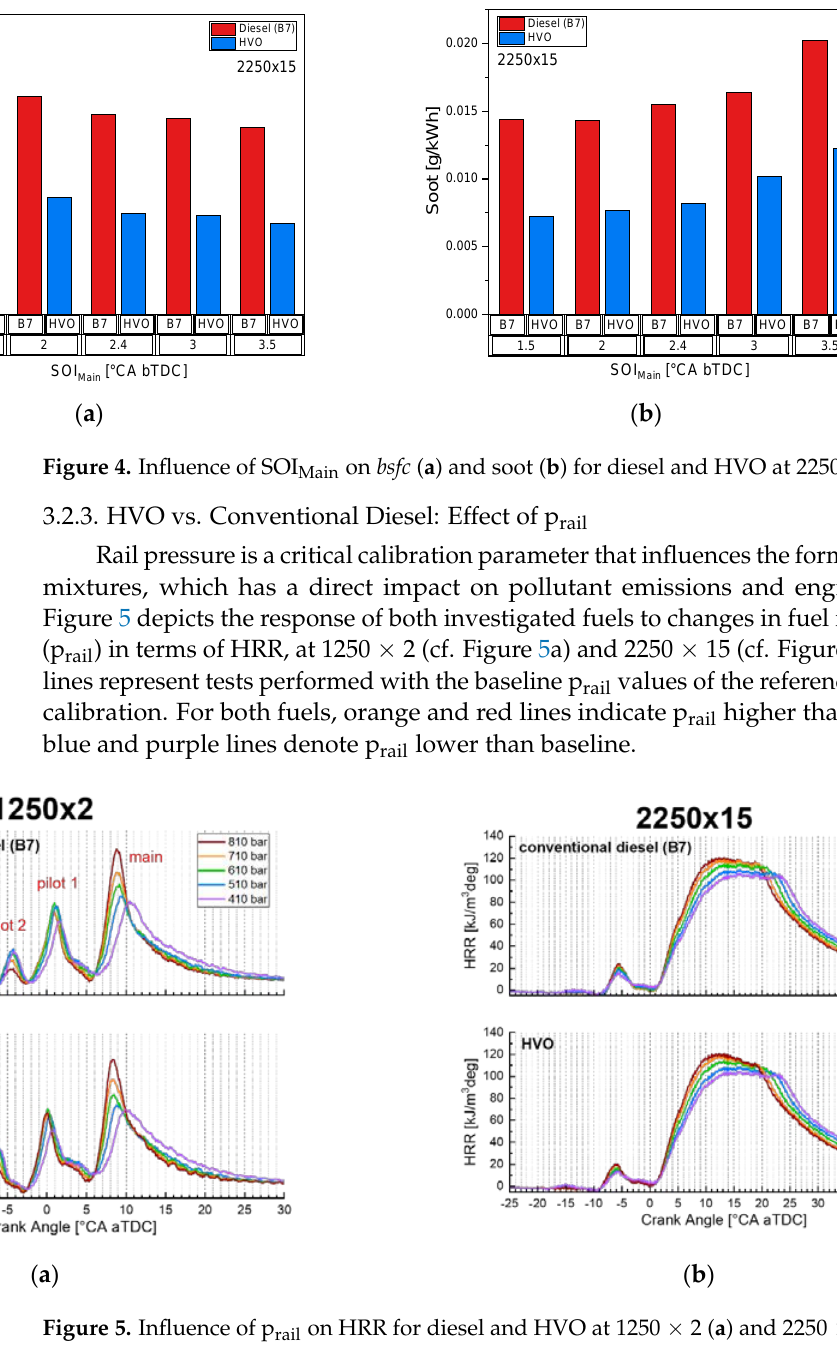
Figure 5. Influence of p rail on HRR for diesel and HVO at 1250 × 2 ( a ) and 2250 × 15 ( b ). When p rail is raised above baseline values at 1250 × 2 (i.e., p rail > 610 bar), the main HRR rises and begins sooner. The increased fuel injection pressure causes the fuel spray of the main injection to reach faster the pilot-burning zone, resulting in a shorter ID of the main injection (ID Main ) and a faster, closer-to-TDC combustion process, due to hotter in-cylinder conditions. However, as p rail values are raised from 610 to 810 bar, the earliest HRR of pilot 2 declines, implying that less fuel is burned during this phase, whereas no opposite behavior (i.e., an increase of pilot 2 HRR) occurs when p rail is decreased from 610 to 410 bar. This may happen because injecting the fuel earlier and with faster spray penetration velocities (due to p rail greater than 610 bar), combined with the low boost pressure values usually featured at low load, may cause wall-wetting phenomena, which do not seem to occur for rail pressures lower than 610 bar as well as for higher